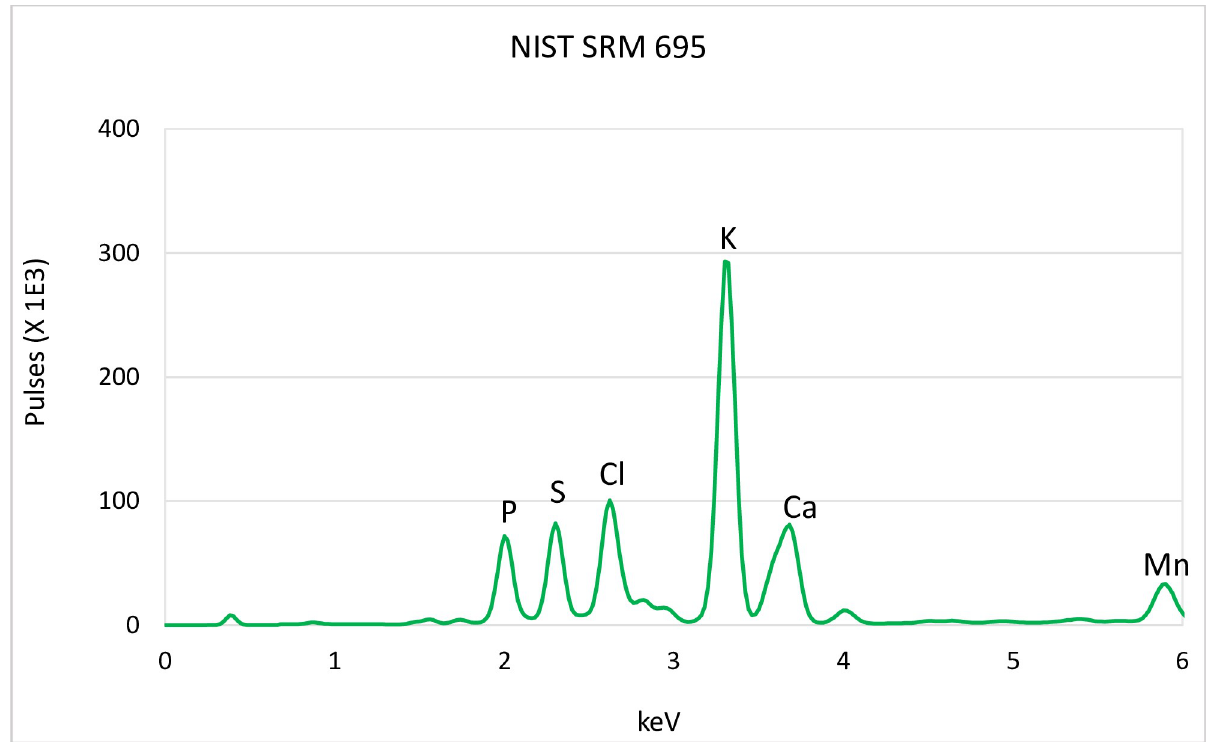
Fig 5. pXRF spectrum of NIST 695 showing energy lines for selected elements including for S.